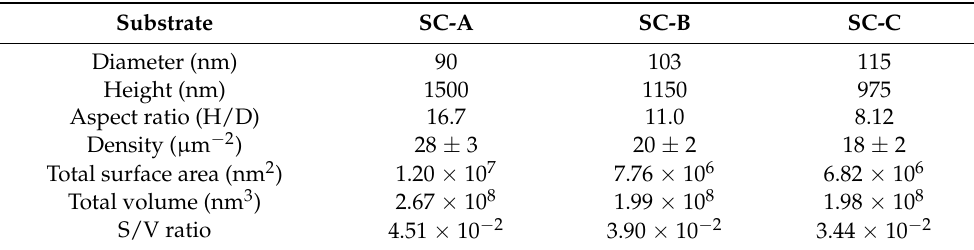
Table 2. Diameter (D), height (H), aspect ratio (H/D), density, total surface area (S), total volume (V), and S/V ratio of ZnO nanoflower arrays on different substrates with a synthesis time of 60 min. Substrate SC-A SC-B SC-C Diameter (nm) 90 103 Height